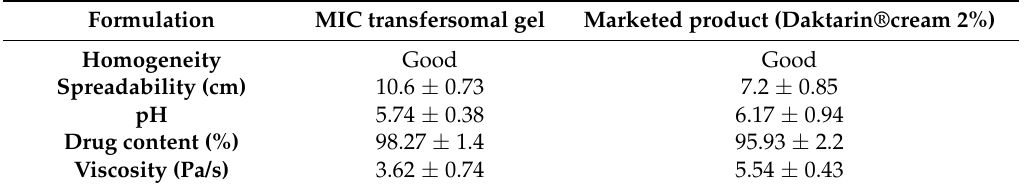
Table 7. Evaluation of MIC transfersomal gel in comparison to Daktarin®cream 2%.